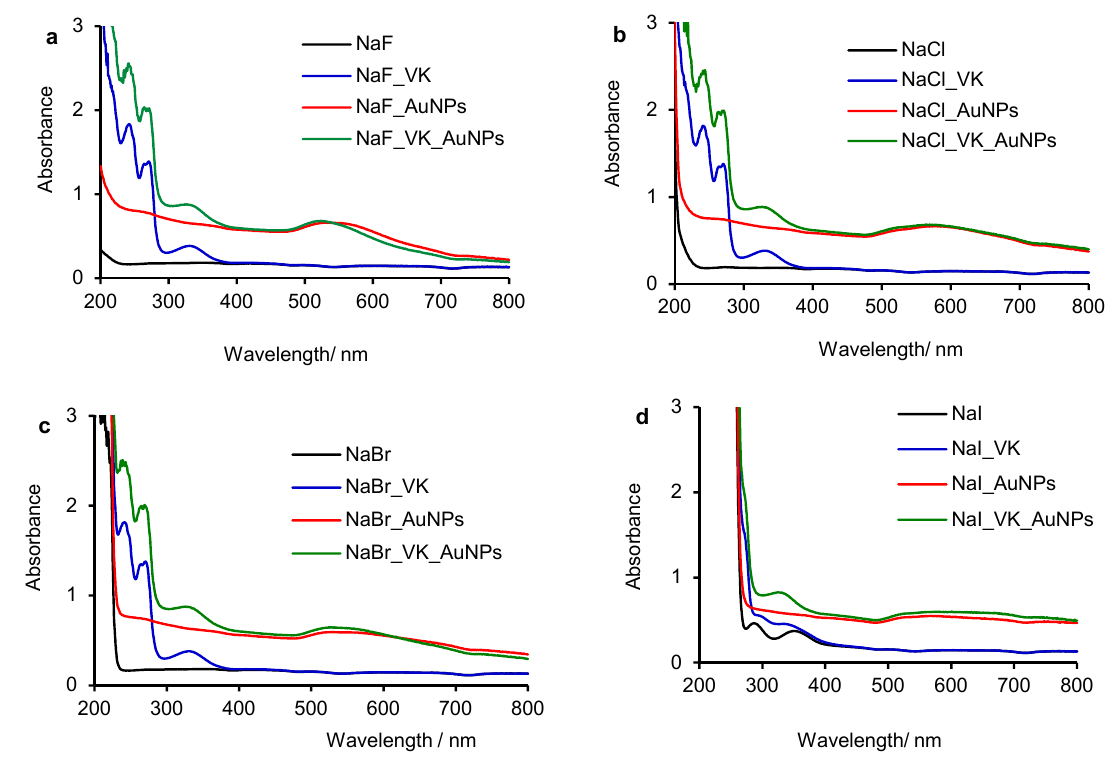
Figure 2. UV-Vis spectra of vitamin K (VK) in concentration of 6.65 × 10 − 5 mol · L − 1 , in the absence and presence of 75 mg · L − 1 AuNPs: ( a )—in 0.1 mol · L − 1 NaF solution; ( b )—in 0.1 mol · L − 1 NaCl solution; ( c )—in 0.1 mol · L − 1 NaBr solution; ( d )—in 0.1 mol · L − 1 NaI solution.